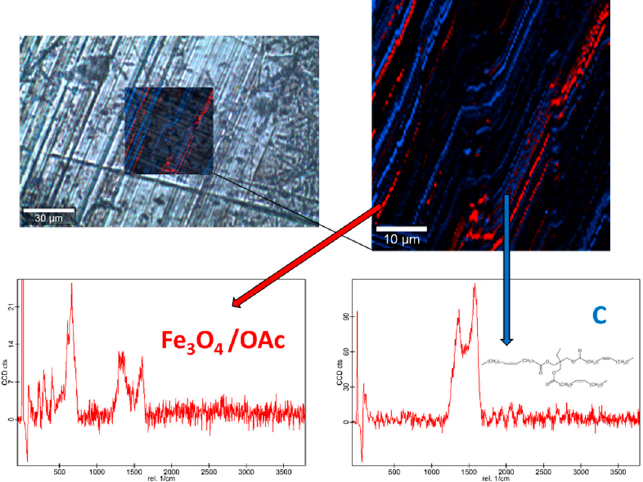
Figure 14. Raman spectra and elemental mapping of the worn surface obtained with the nanolubricant of Nd alloy (19 nm) nanoparticles.